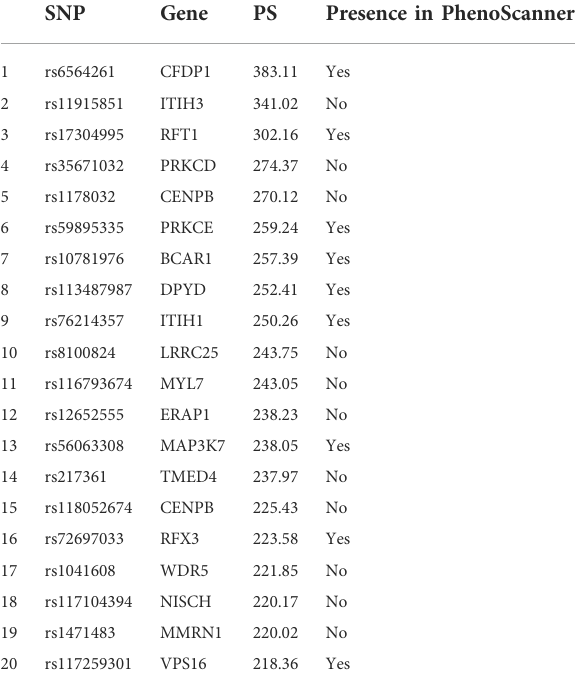
TABLE 1 PS values of the top 20